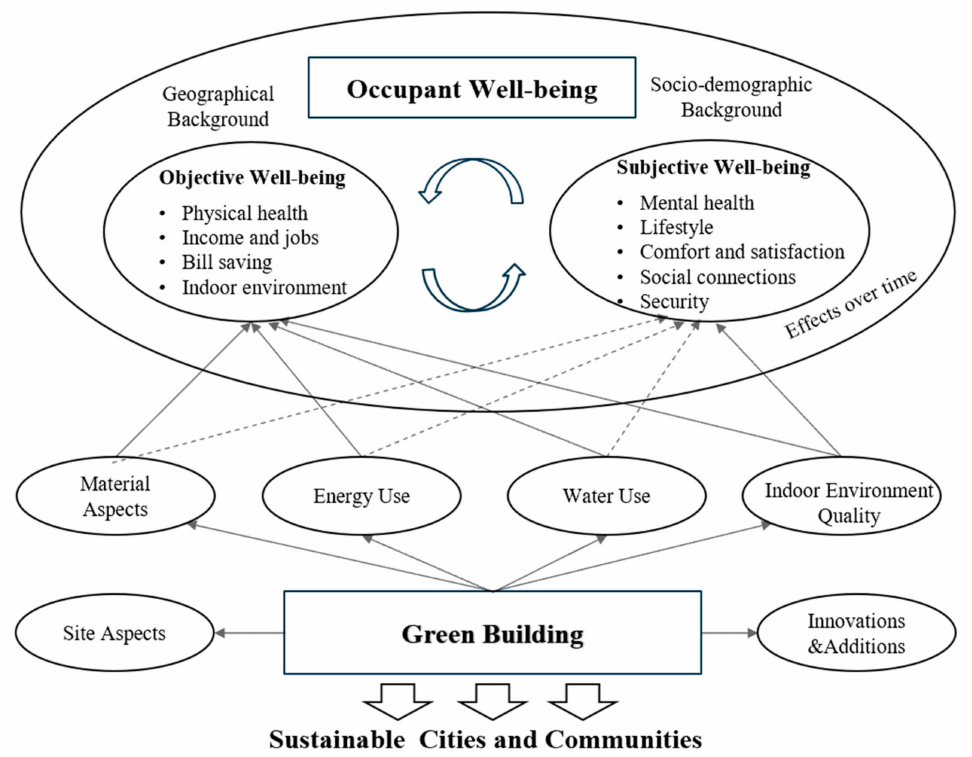
Figure 4. Conceptual framework for improvement in occupant well-being brought about by green